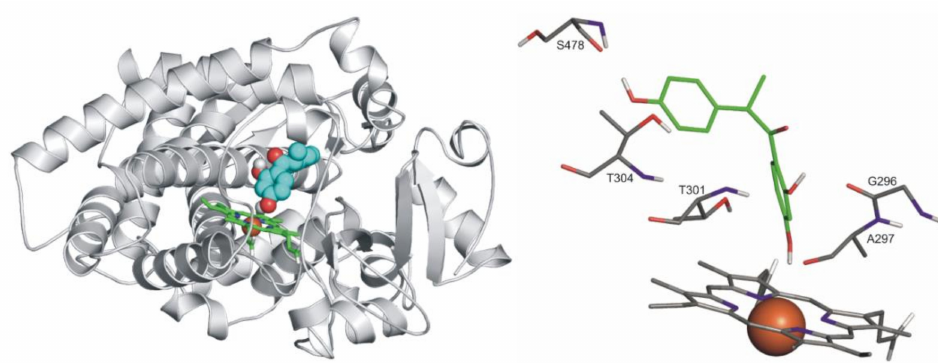
Figure 9. Left: The binding mode of R -DESMA (space-filling) as docked to the binding pocket of CYP2C9 enzyme (teal cartoon) above the heme ring (green sticks). Right: The close-up of binding mode of R -DESMA (green sticks) as docked to the binding pocket of CYP2C9 enzyme above the heme ring (Fe 3 + ion in orange). Interacting enzyme residues are labelled and shown as thin sticks. Interacting